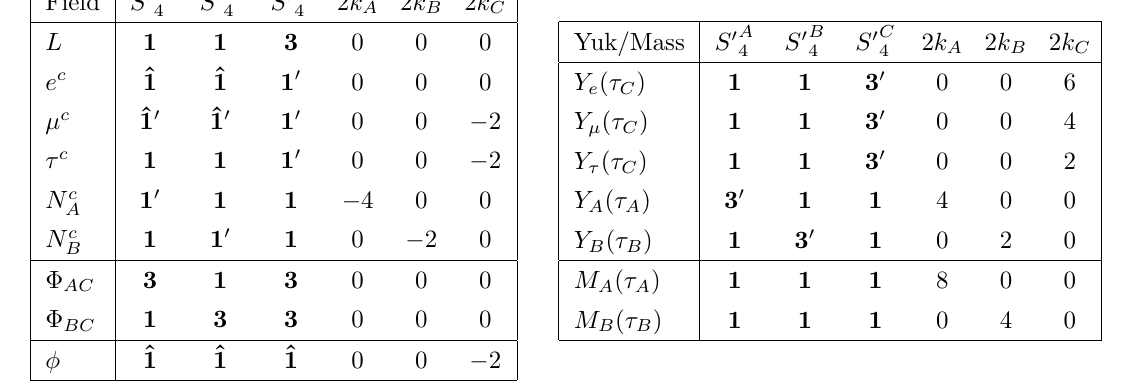
Table 8 . Assignments of fields for the alternative weighton version of the model.